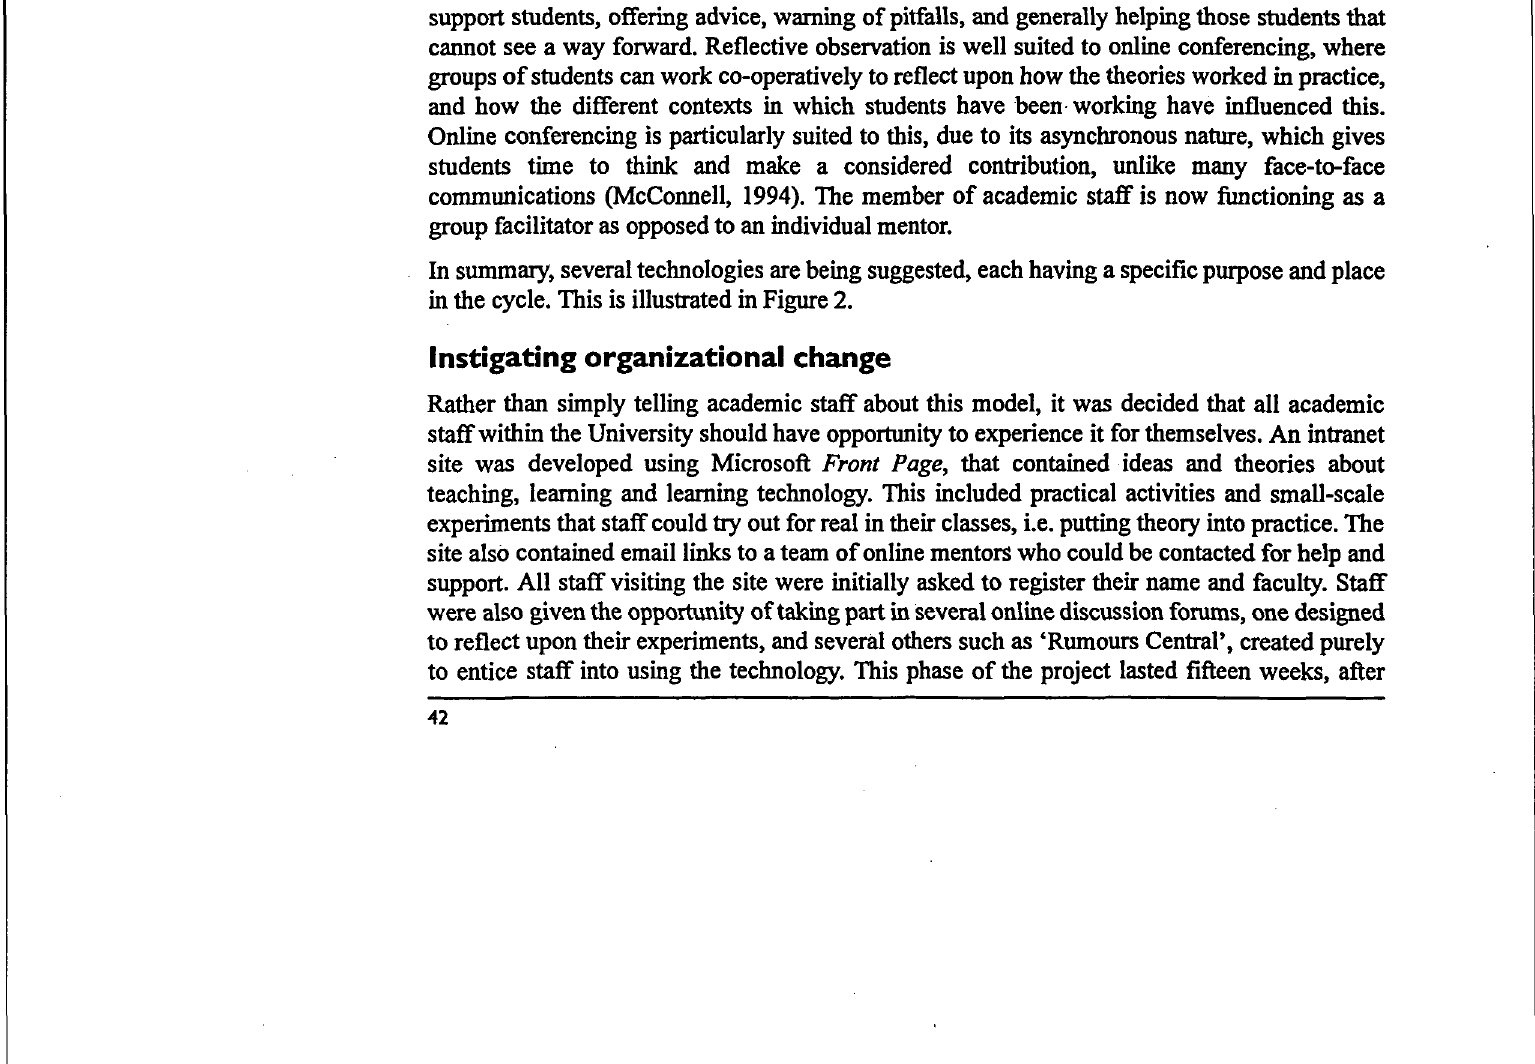
Figure 2: A model for applying learning technology to the experiential learning